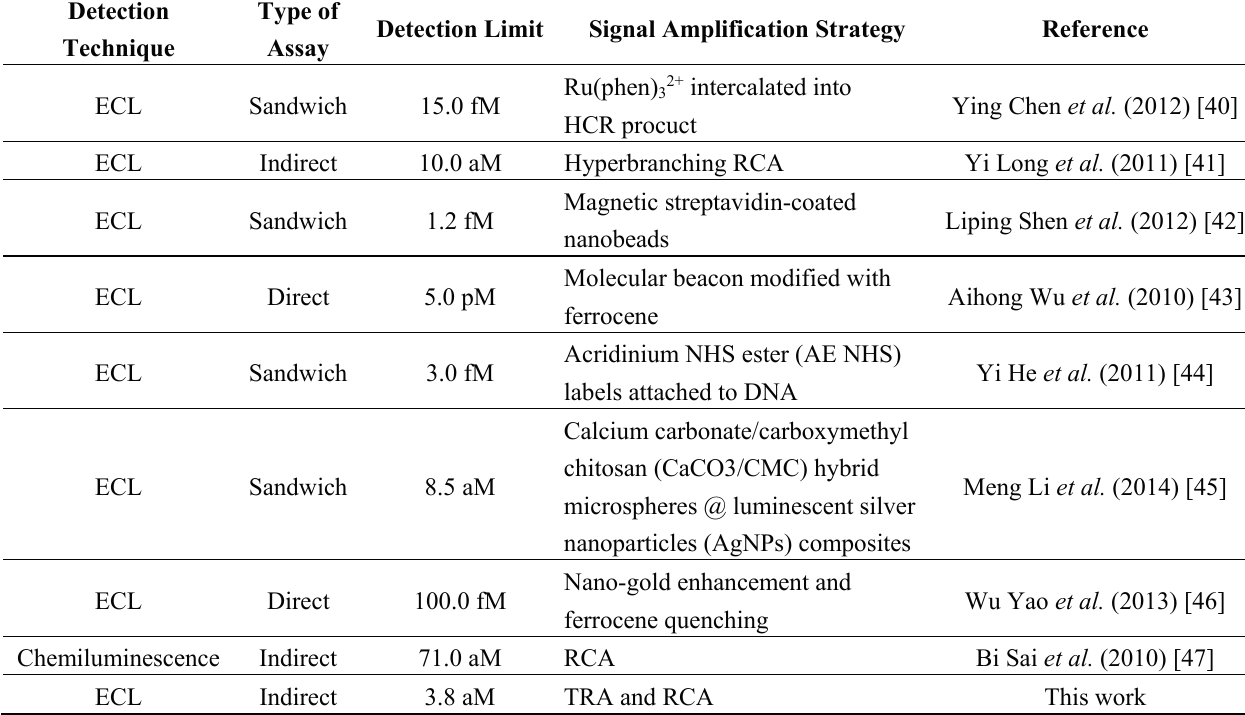
Table 3. Comparison of the proposed electrochemiluminescent(ECL) sensor with some reported